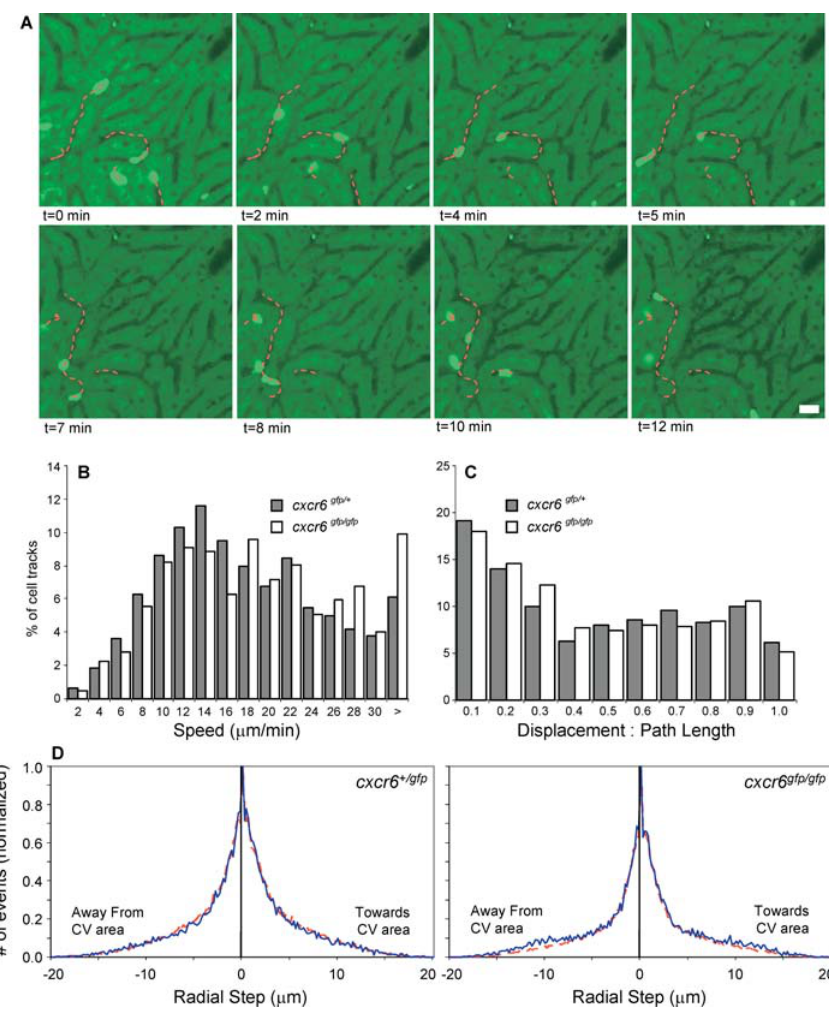
Figure 2. CXCR6 þ Lymphocytes Patrol Liver Sinusoids (A) Select confocal microscopic images from intravital videos of liver of an anesthetized cxcr6 gfp/ þ mouse (40 3 magnification). CD1d-reactive cells (bright green) can be seen migrating along hepatic sinusoids at an average speed of 16 l m/min. Scale bar is 25 l m. Cell tracks were traced and quantified using Volocity cell-imaging software. Note tracks of cells traveling in opposite directions in the same sinusoid (left side of image, at 0– 5 versus 7–12 min). (B) Velocity quantification of GFP þ lymphocytes. Videos of liver in cxcr6 gfp/ þ and cxcr6 gfp/gfp mice (10 3 magnification) were analyzed for the velocity of GFP þ cells in 640 cell migration tracks for cxcr6 gfp/ þ mice and 574 cell migration tracks for cxcr6 gfp/gfp mice. Results demonstrate similar velocities of cells with the cxcr6 gfp/ þ (filled bars, average velocity 16.5 6 8.3 l m/min) and cxcr6 gfp/gfp genotypes (unfilled bars, average velocity 18.4 6 9.5 l m/min). (C) Analysis of directedness of cell migration. The same cell tracks as in (B) were analyzed for ratio of overall cell displacement to stepwise-summed path length. Results demonstrate similar degrees of directed crawling by cells from cxcr6 gfp/ þ (filled bars, average 0.44 6 0.31) and cxcr6 gfp/gfp (unfilled bars, average 0.42 6 0.30) mice. (D) Analysis of crawling relative to blood flow in peri-central vein areas of cxcr6 gfp/ þ and cxcr6 gfp/gfp mice. Histograms represent the frequency of cell movements made towards or away from nearby draining areas in likely close proximity to central veins (solid blue curve). The radial step of a cell is the cellular displacement along the axis defined by the cell’s initial starting point to the central vein. The same step distances were assigned random orientations and the resultant data were plotted (red dashed curves). DOI: 10.1371/journal.pbio.0030113.g002